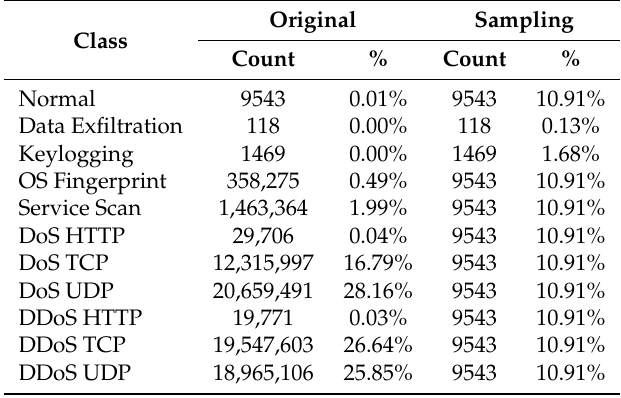
Table 3. Comparison between the number of instances of each class in the Bot-IoT dataset before and after applying stratified sampling with a maximum cut of 9543 samples per